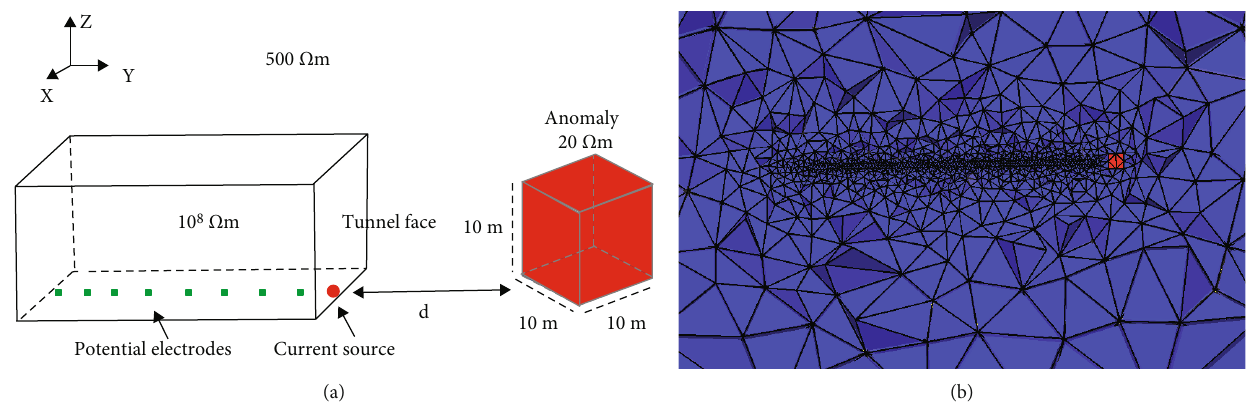
Figure 5: (a) Schematic diagram of low-resistance model. (b) Unstructured mesh used in the FE simulation.